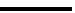
Figure 6: Finite state transition diagramme for English auxiliary verb affixation dependencies (restricted to one modal auxili- ary